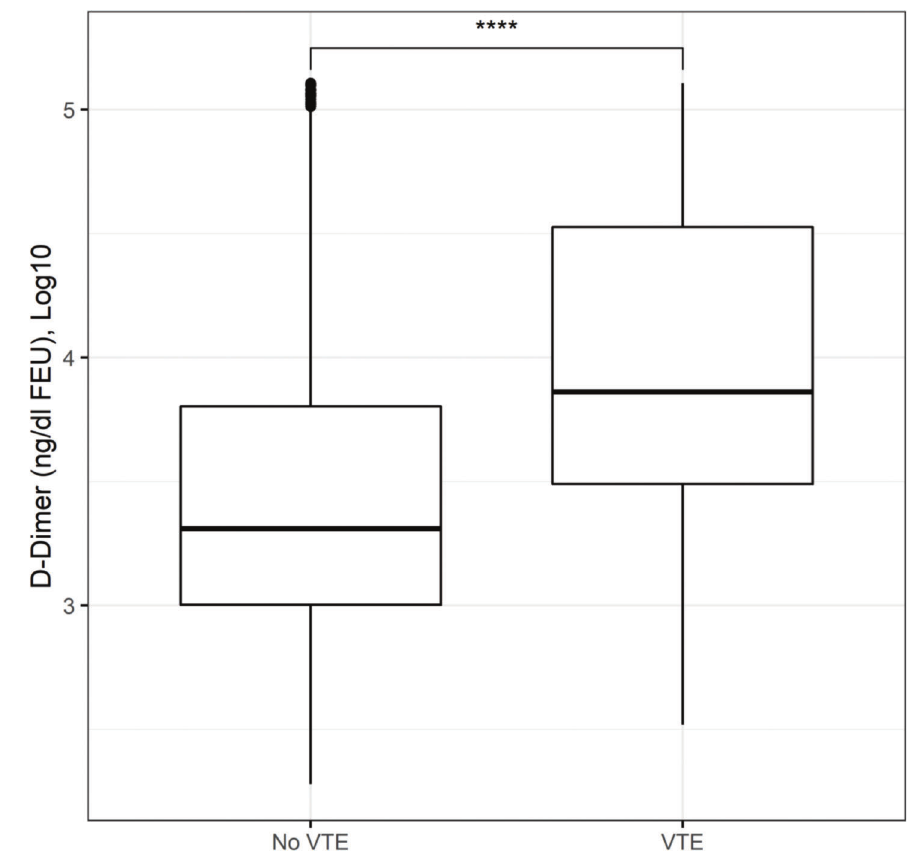
Figure 4 - Box plot of Log 10 D-Dimer stratified by the occurrence of venous thromboembolism (VTE). This box plot shows a large overlap of D-dimer levels among patients with or without VTE in this cohort, suggesting a low discriminative ability in this